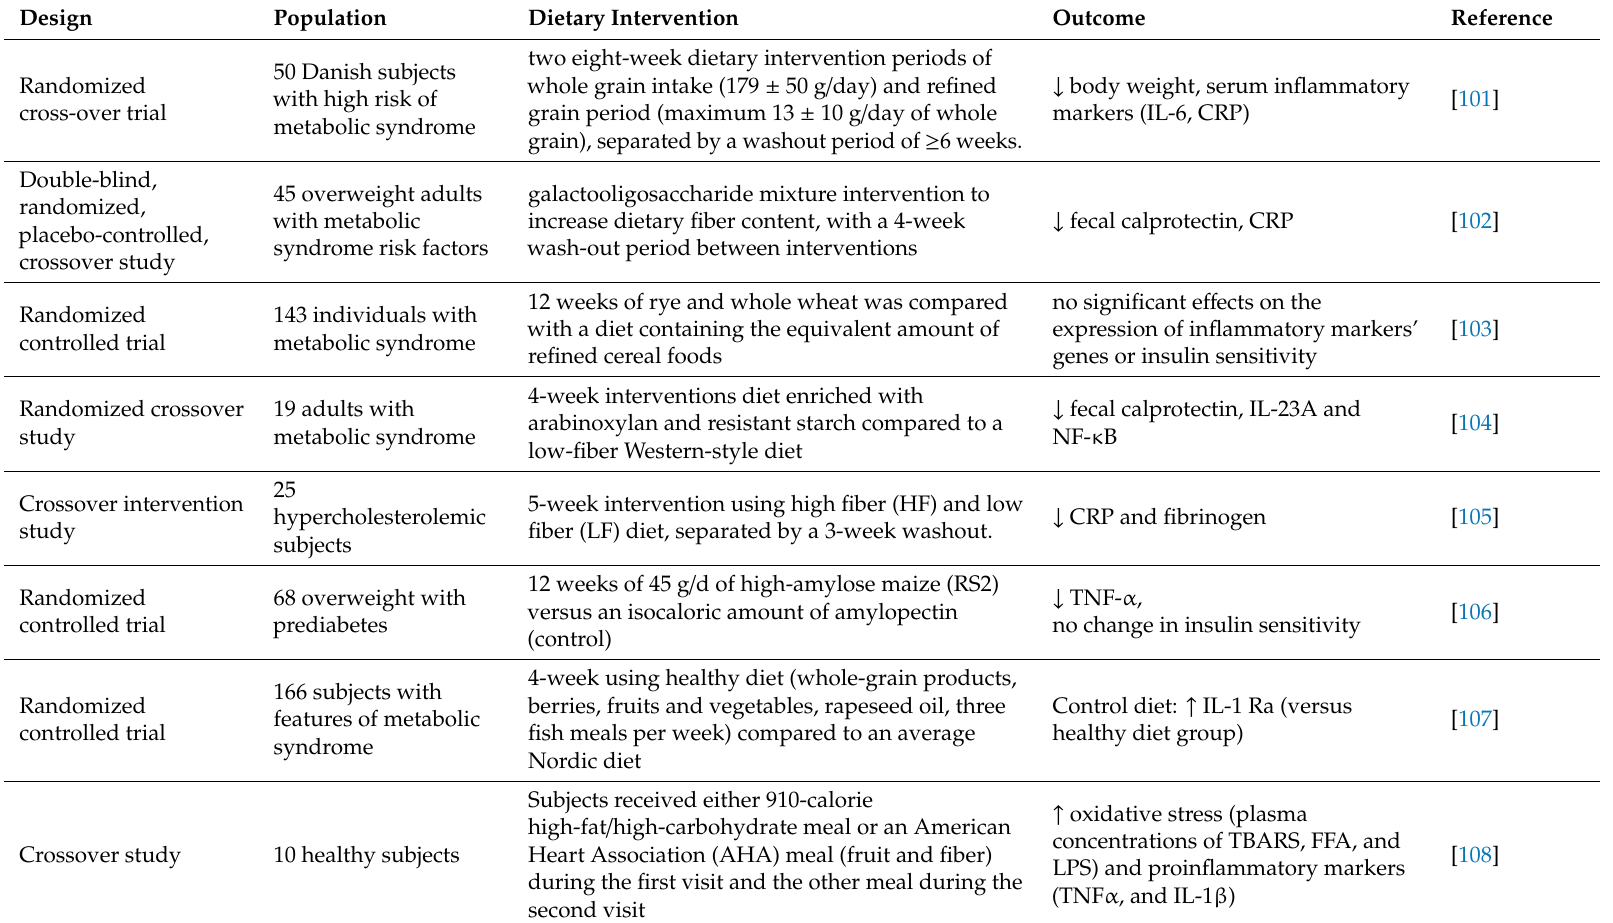
Table 1. Clinical studies regarding the e ff ect of high fiber intake on inflammatory markers in obesity and associated